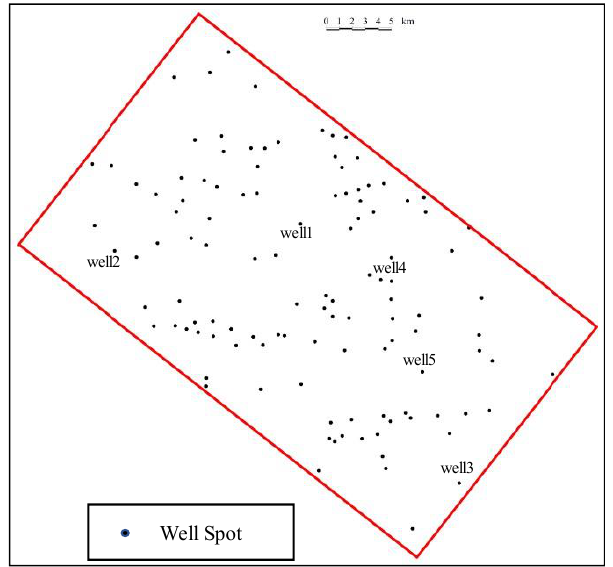
Figure 3. Base map of the study area (the red square is the boudary of the project shown in the Figure 1). The wells utilized in the study are written by their names.